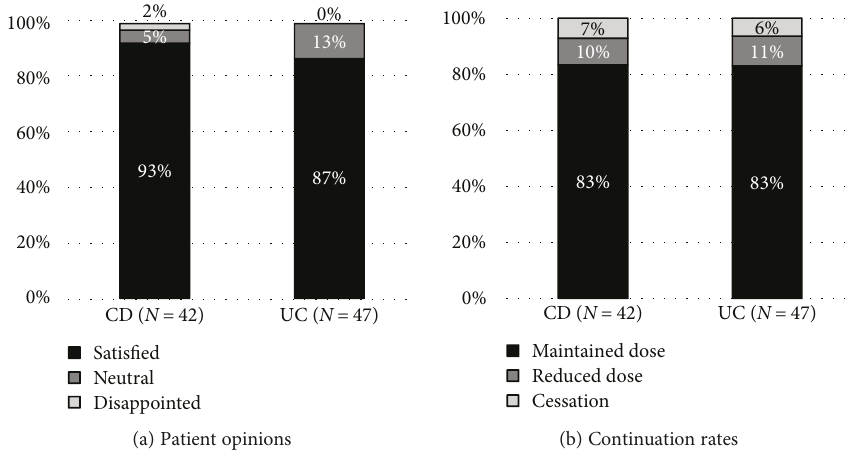
Figure 6: Patient opinions about herbs and botanicals (a) and continuation rates of conventional medication (b) among IBD patients using herbal products. IBD: in fl ammatory bowel diseases; CD: Crohn ’ s disease; UC: ulcerative